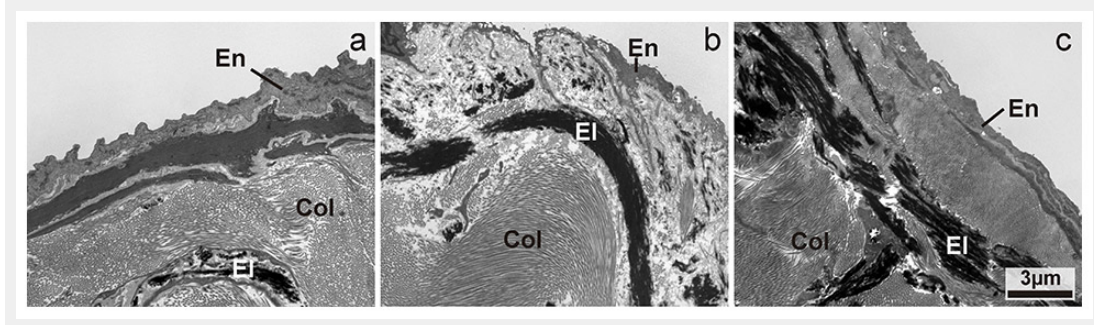
Transmission electron microscopic image of the increasing content in elastin in valves from classes A to C. En: endothelial cells, El: elastin, Col: collagen. Magnification: 3400x.